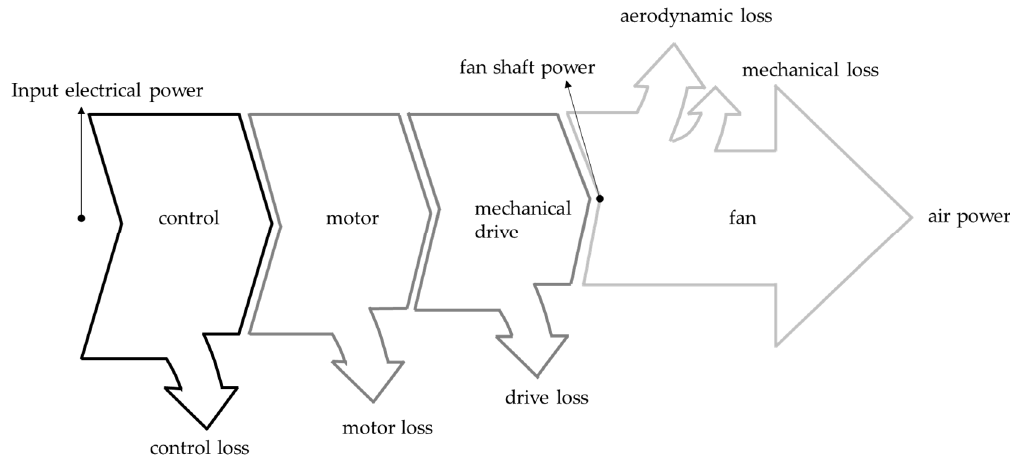
Figure 6. Places where energy losses occur in the